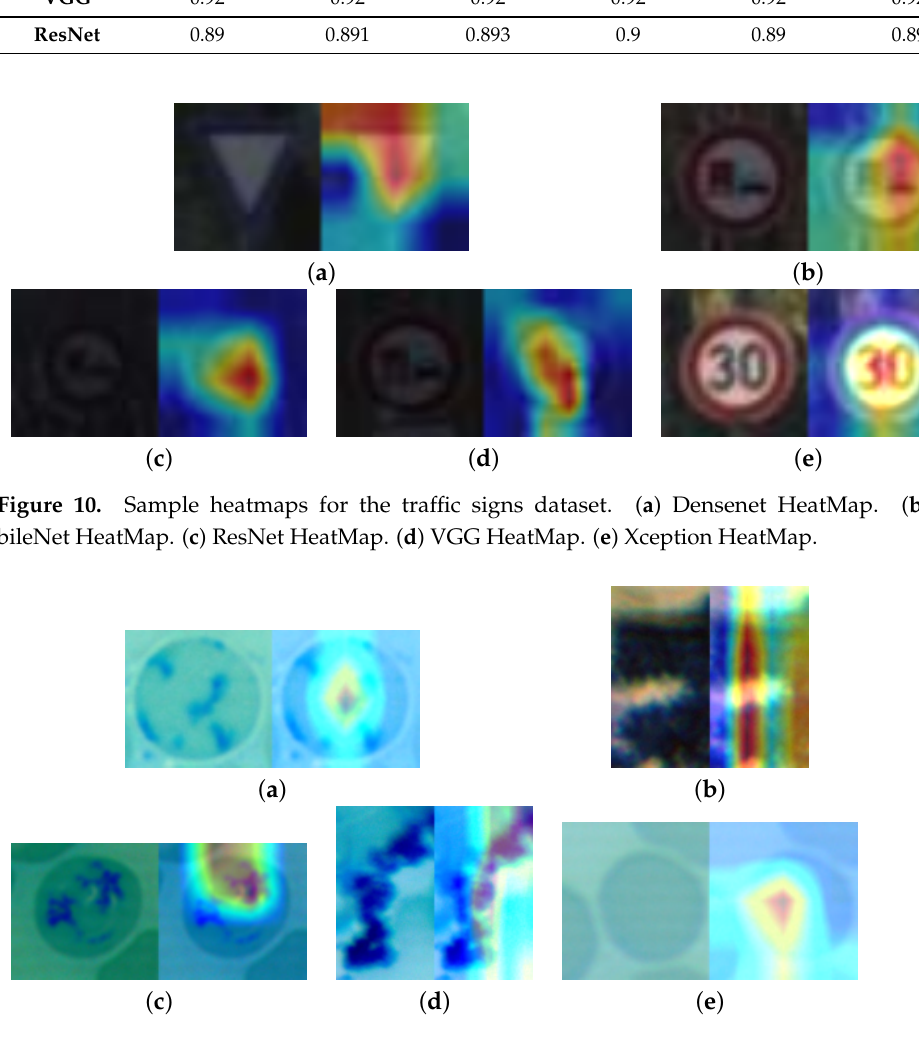
Figure 11. Sample heatmaps for the human reticulocyte dataset. ( a ) Densenet HeatMap. ( b ) Mo- bileNet HeatMap. ( c ) ResNet HeatMap. ( d ) VGG HeatMap. ( e ) Xception